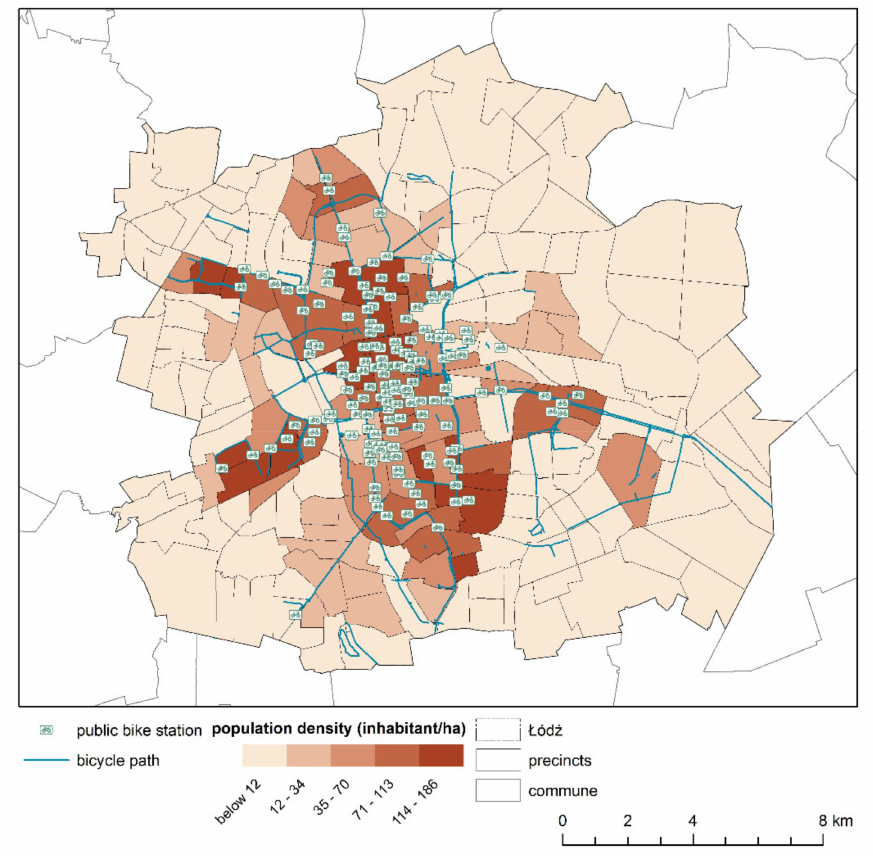
Figure 1. Location of bike docking stations and cycle paths against spatial differentiation of popula- tion density in Ł ó d´z. Source: own elaboration based on data from the Ł ó d´z City Hall, OpenStreetMap, and the Database of Topographic